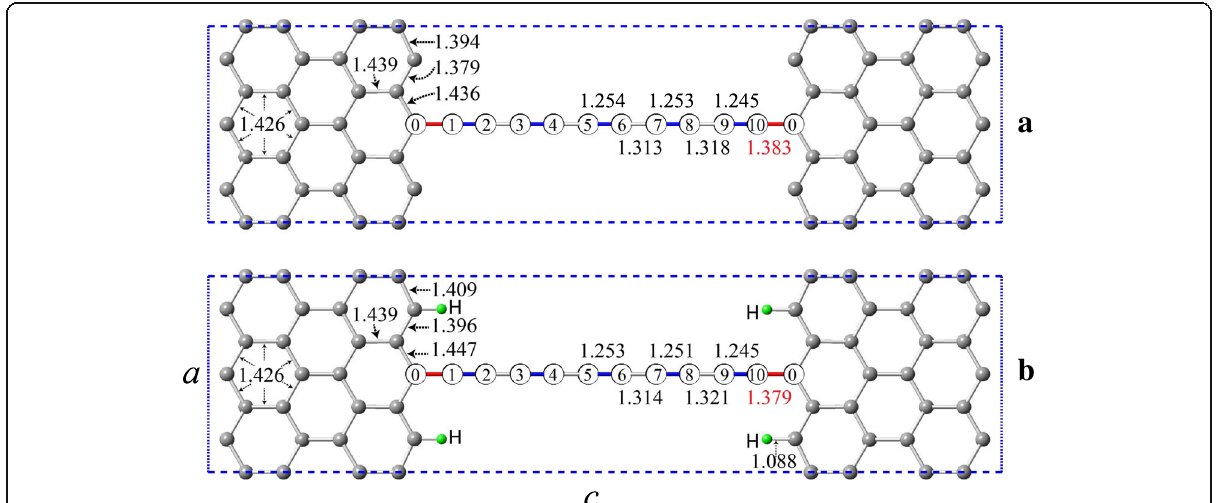
Fig. 1 Elementary cell - a = 7.41 Å, c = 29.98 Å. Thickness of the cell is 10 Å. (bond lengths in the figure are in Å): a – without hydrogen; b – four bonds terminated with